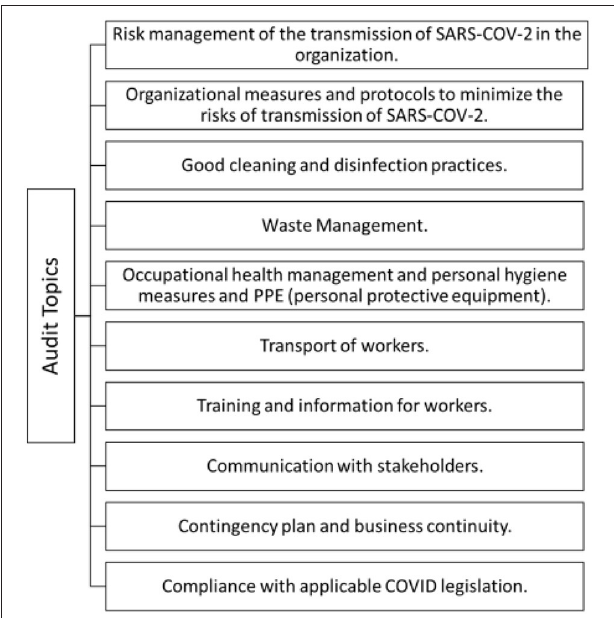
FIGURE 2 | Audit control points (Intedya, 2020).